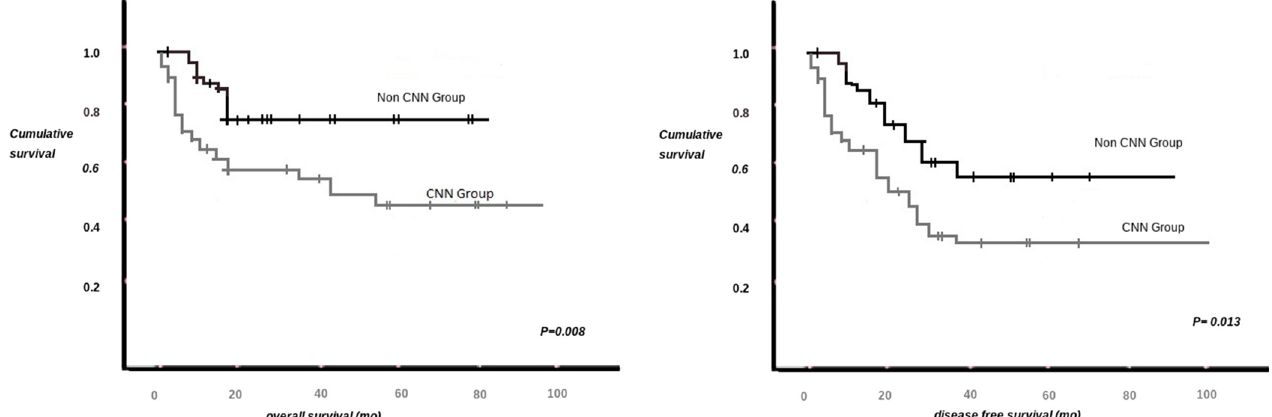
Fig. 2. A,B — Kaplan-Meier graph showing overall survival and disease-free survival rates of patients with tongue squamous cell carcinoma with cervical nodal necrosis (CNN group) or without CNN (non-CNN group) on preoperative